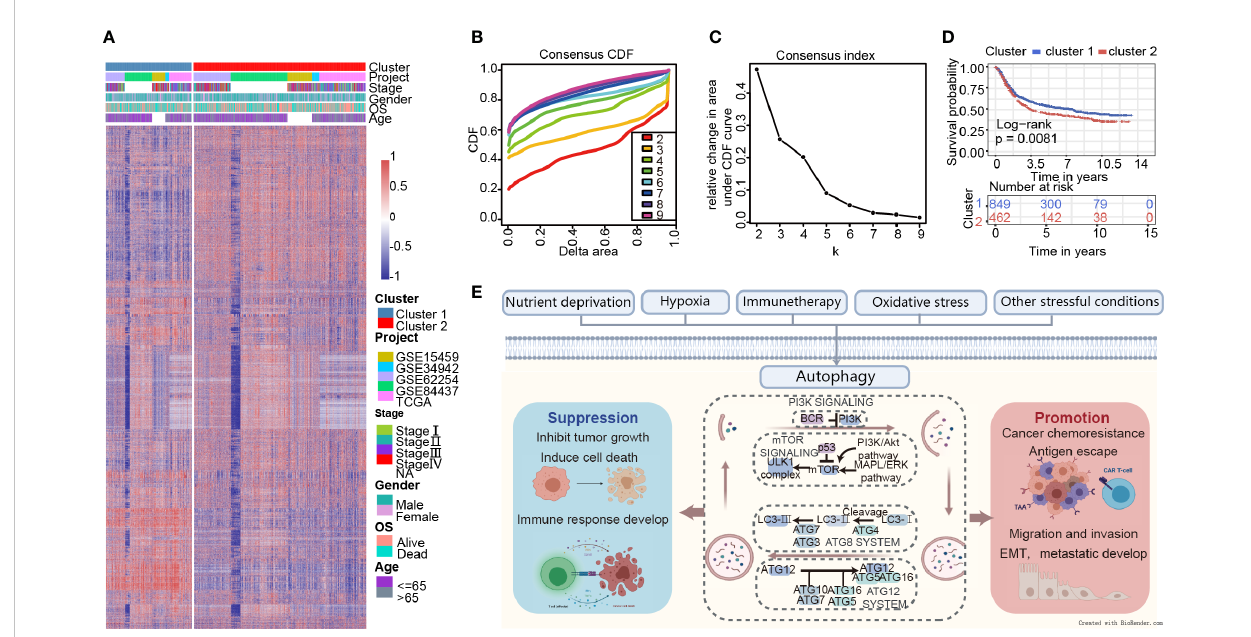
FIGURE 2 Consensus clustering indicates that 2 clusters are the greatest number of stable clusters across clustering techniques. (A) Heatmap of gene expression with the project, stage, gender, OS, and age between cluster 1 and 2. (B) Consensus clustering cumulative distribution function (CDF) for k = 2 to k = 9. (C) Relative change in area under CDF curve according to various k values. (D) Survival analysis of Cluster 1 and Cluster 2 in the training set. (E) Schematic diagram for the molecular machinery of autophagy and the dual role of autophagy in cancer